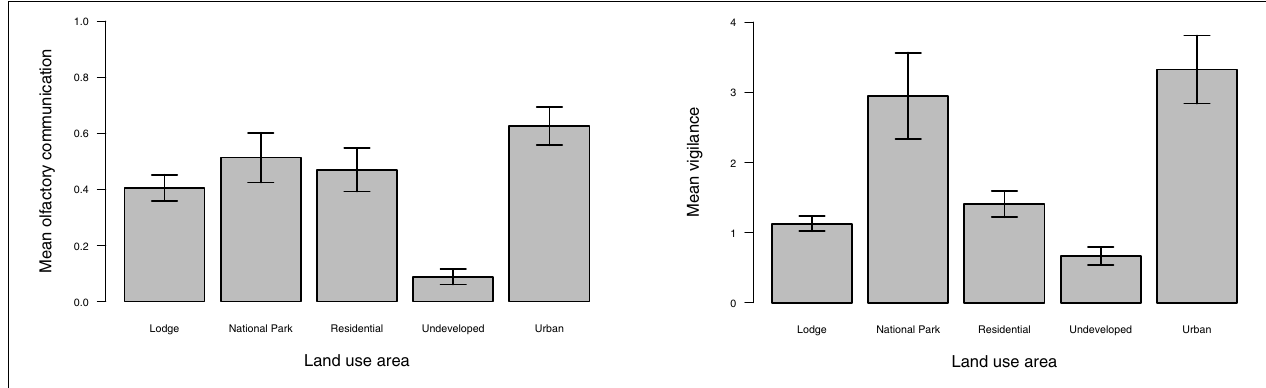
FIGURE 2 | Mean frequency of olfactory and vigilance behaviors observed by land use. Bars represent the standard error. TABLE 2 | Vigilance and olfactory communication by land use. Olfactory